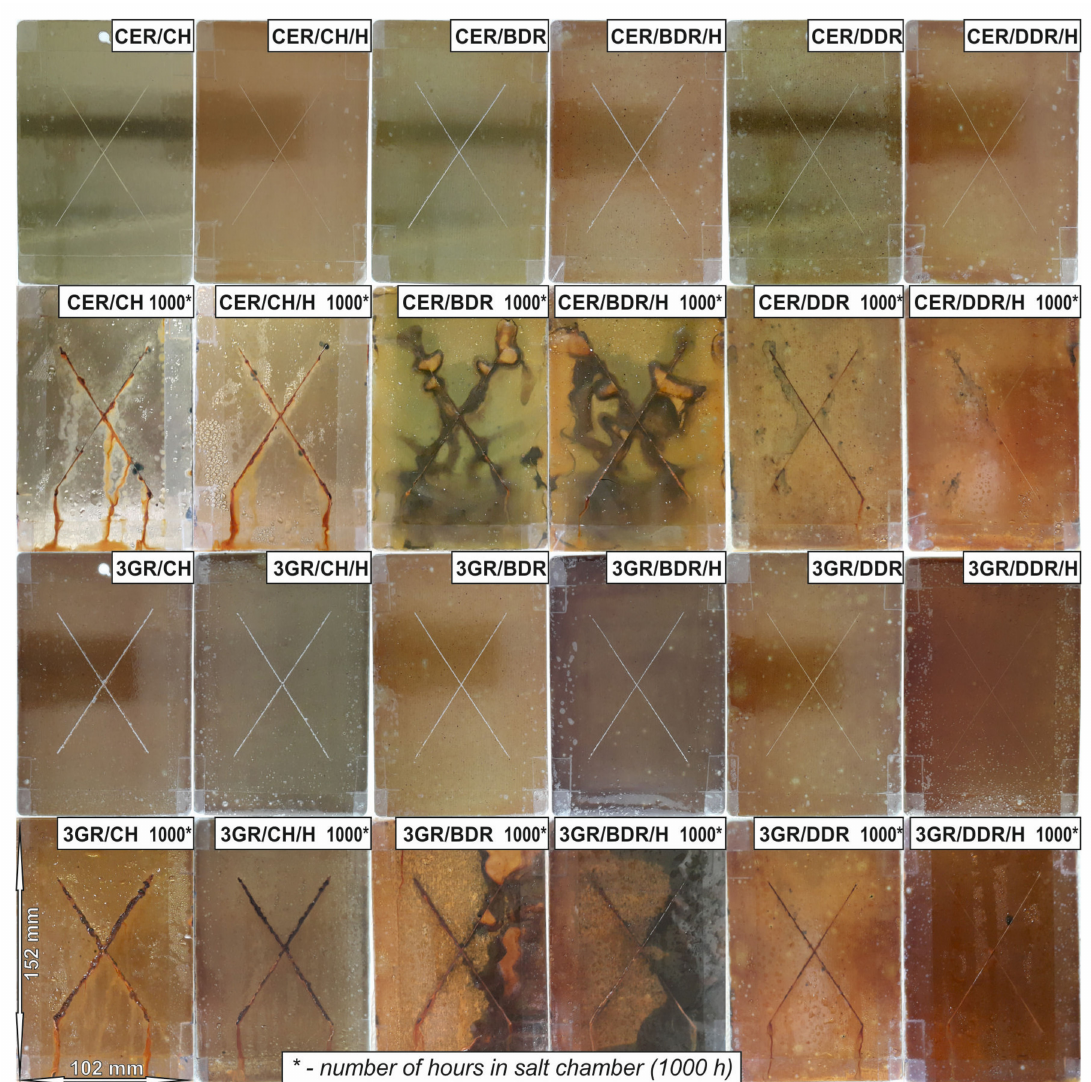
Figure 6. Prepared coatings before and after 1000 h of salt spray test. Investigation of the prepared coatings functional properties was completed by the determination of samples gloss and color, as well. The results are presented in Table 2. Colors of unfilled samples, matching the RAL color chart, were described as shades of yellow, gold, green, beige, grey and brown, while coatings with modified halloysite showed grey, beige, and brown shades. In general, the presence of natural components, both rosin derivatives and halloysite contributed to the noticeable darkening of coatings color. On the other hand, the influence of these components on coatings gloss was not so visible, but measurable. All coatings with halloysite showed reduced gloss in comparison with unfilled samples. Beneficially, all results of color and gloss were within the discretionary acceptability of the potential end